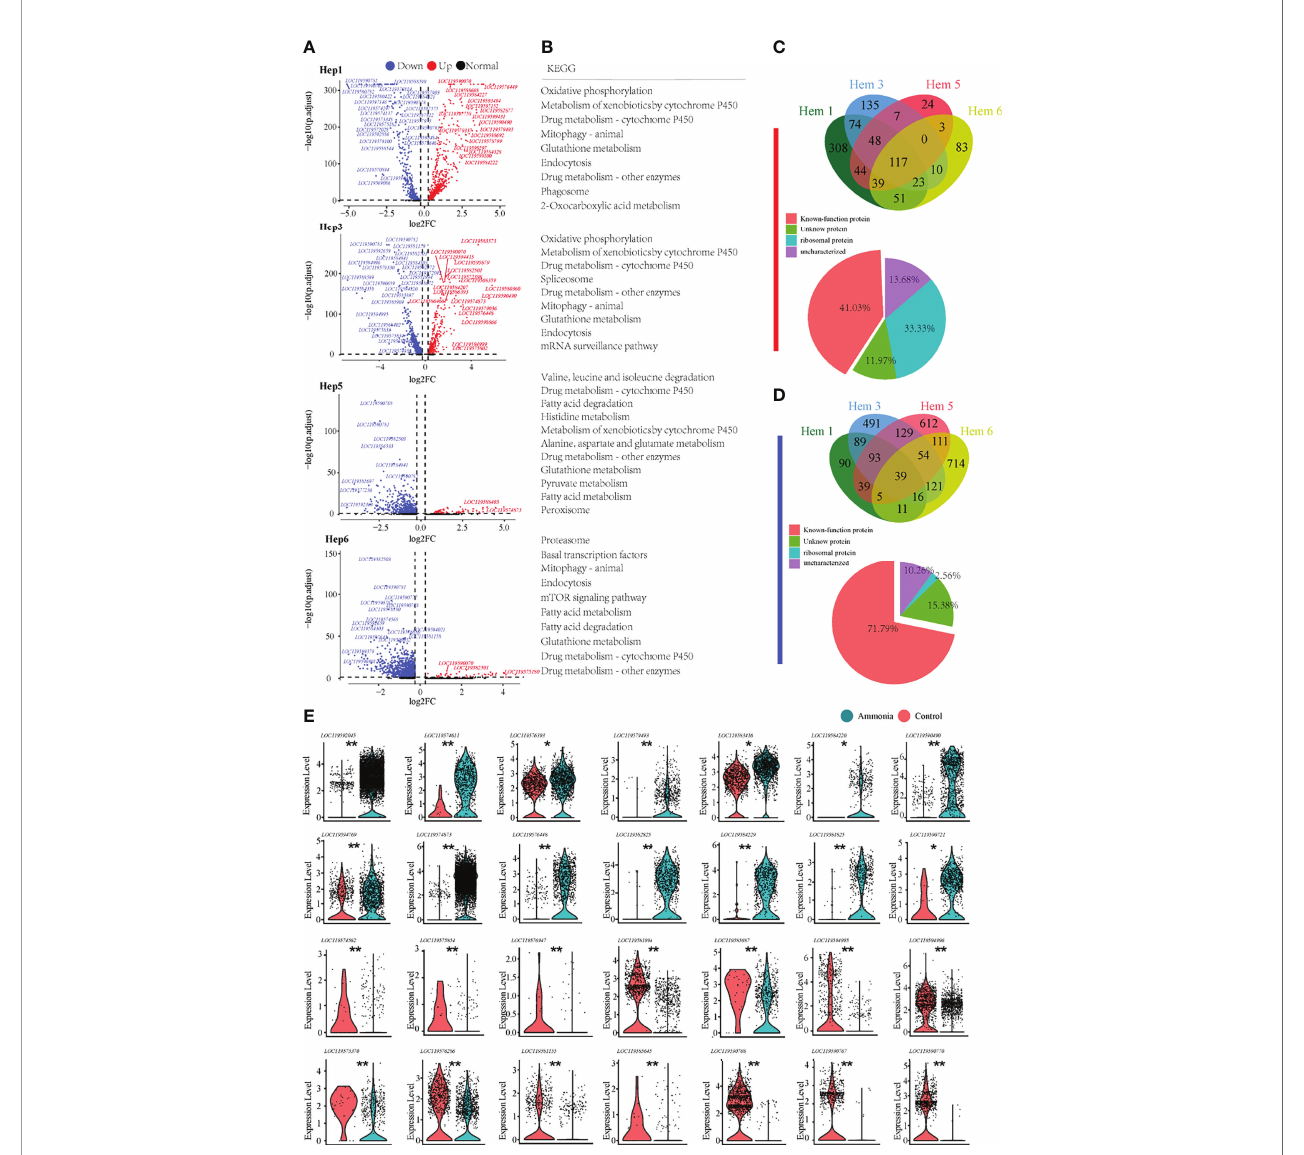
FIGURE 5 | Enrichment analysis of differentially expressed genes in P. monodon hepatopancreatic cells under ammonia-stress. (A) Differential gene volcano map display of Hep1/3/5/6 clusters. (B) KEGG enrichment analysis of differential genes in Hep1/3/5/6 clusters. (C) The Venn diagram of coupregulated genes and its gene function in hepatopancreatic cells. (D) The Venn diagram of codownregulated genes and it gene function in hepatopancreatic cells. (E) Violin diagram showing functional genes in hepatopancreatic cells. (*p < 0.05 and **P <